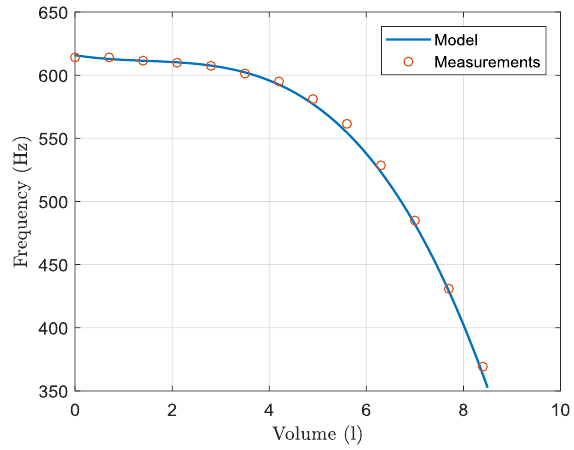
Figure 13. The measured frequency vs. model.